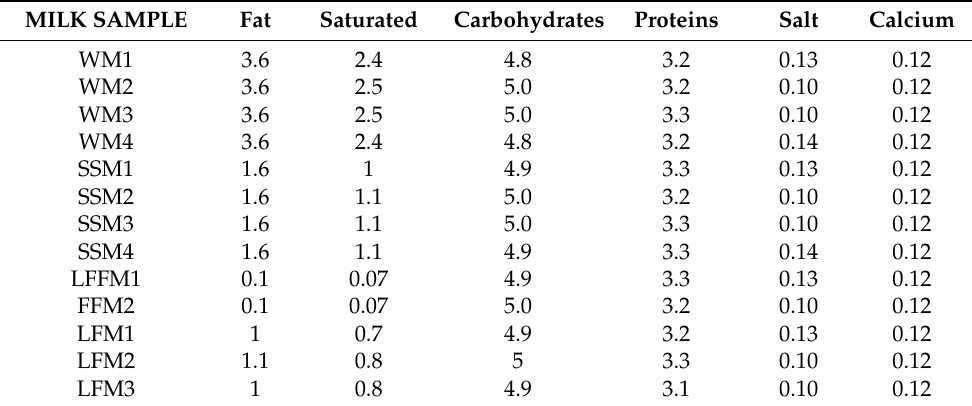
Table 1. Main nutritional values * of milk samples. MILK